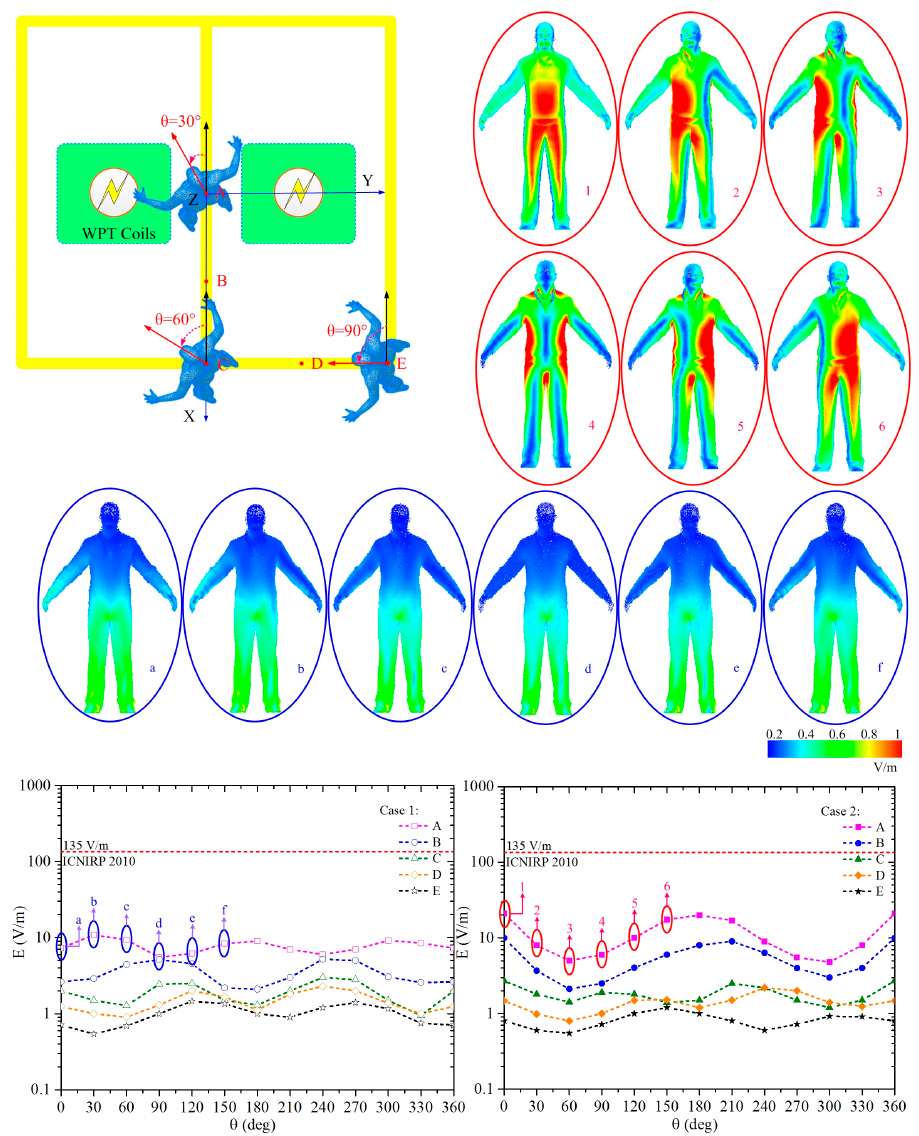
Figure 8. The maximum induced electric field in a standing human body with different orientations around the two WPT systems.